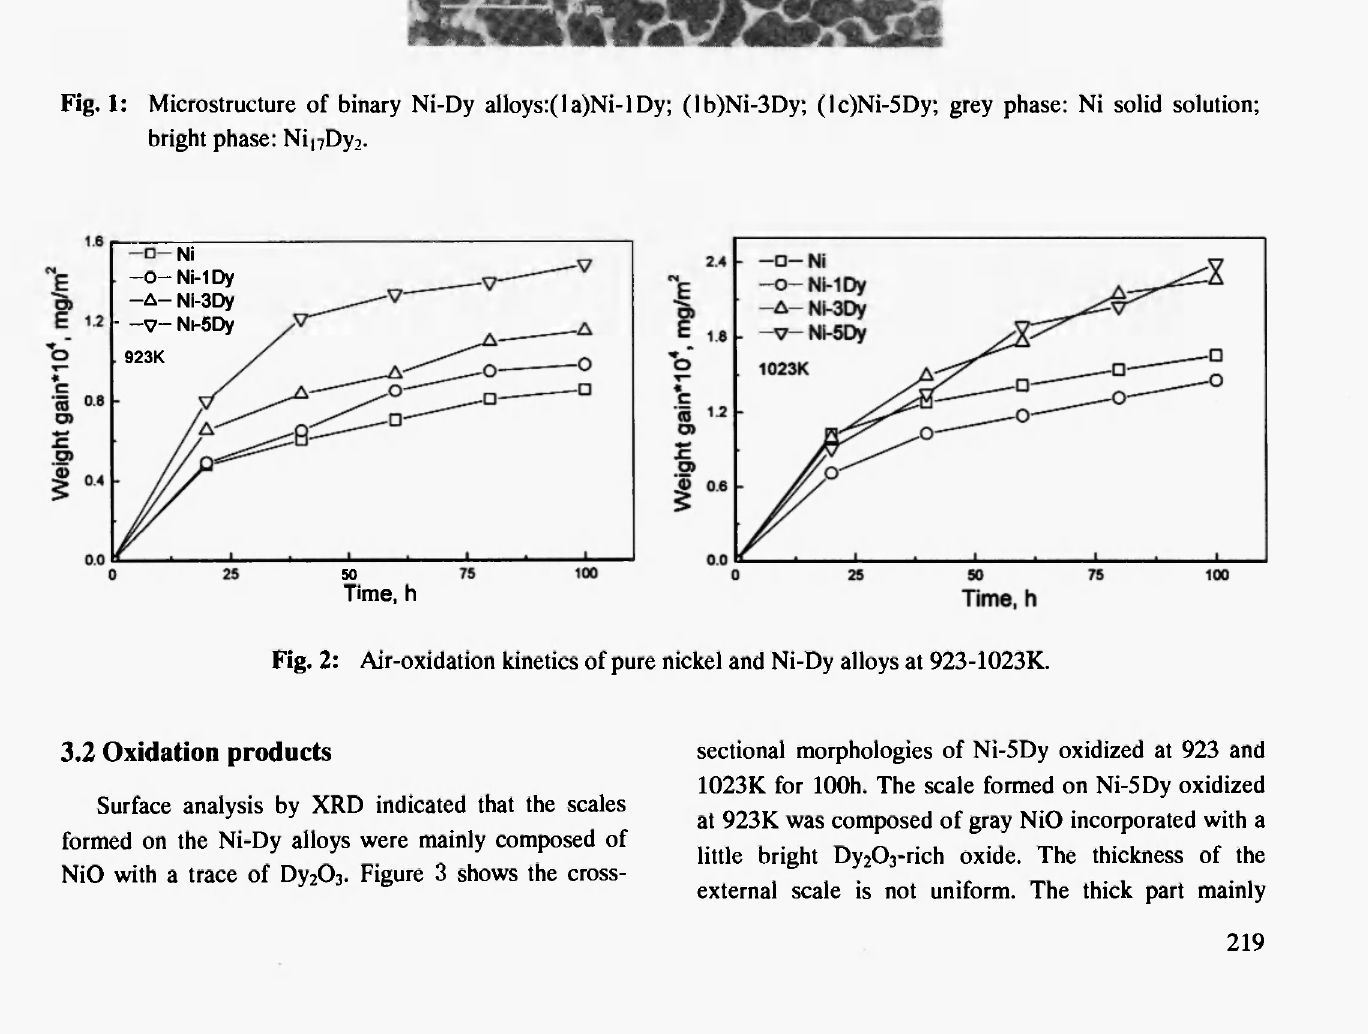
Fig. 1: Microstructure of binary Ni-Dy alloys:(la)Ni-lDy; (lb)Ni-3Dy; (lc)Ni-5Dy; grey phase: Ni solid solution; bright phase: Ni| 7 Dy 2 .